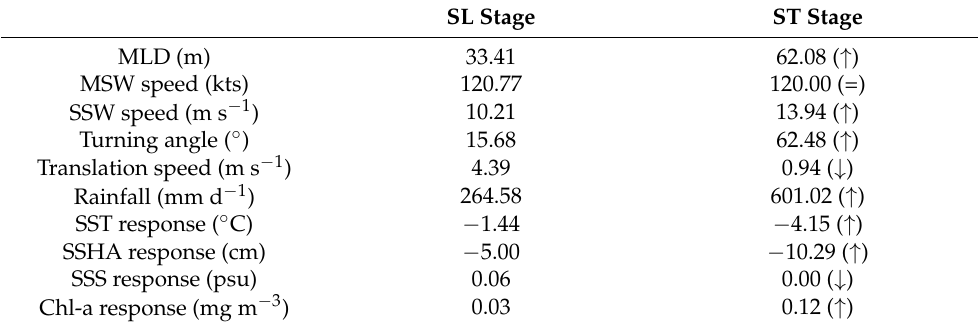
Table 1. Quantitative impact factors and biophysical responses in the two Category 5